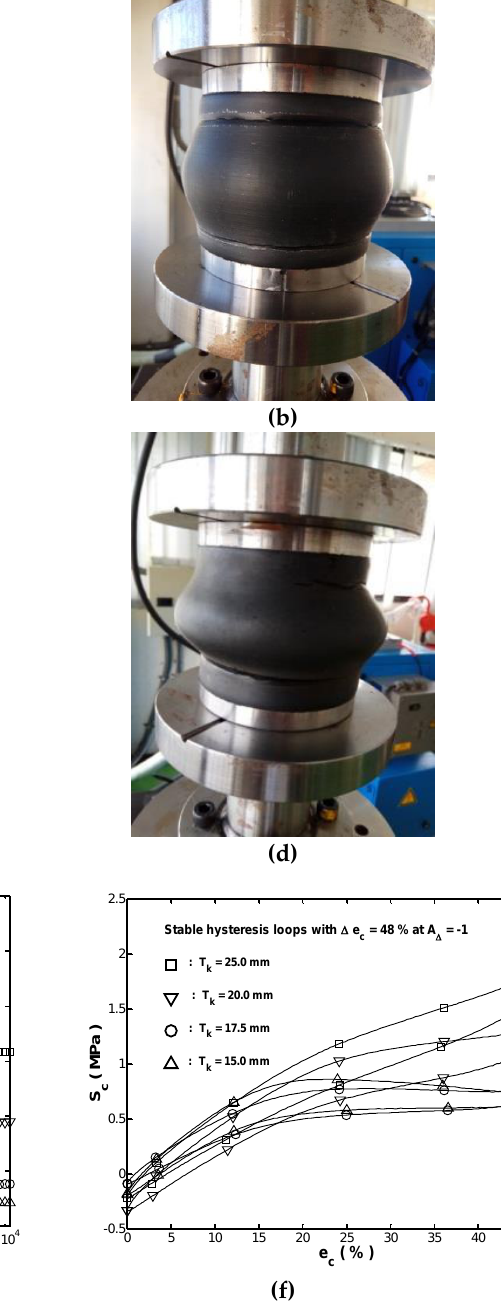
Figure 4. Deformations of the tested sample after cyclic compression tests: ( a ) 𝑇 𝑘 = 25.0 mm at the cyclic loading number of 11,894; ( b ) 𝑇 𝑘 = 20.0 mm , ( c ) 𝑇 𝑘 = 17.5 mm , and ( d ) 𝑇 𝑘 = 15.0 mm at the cyclic loading number of 10,000; ( e ) Relationship between the stress range and number of cycles; ( f ) Stable hysteresis loops in cyclic compression tests with a strain range of ∆𝑒 𝑐 = 48% for four different wall-thickness scales.